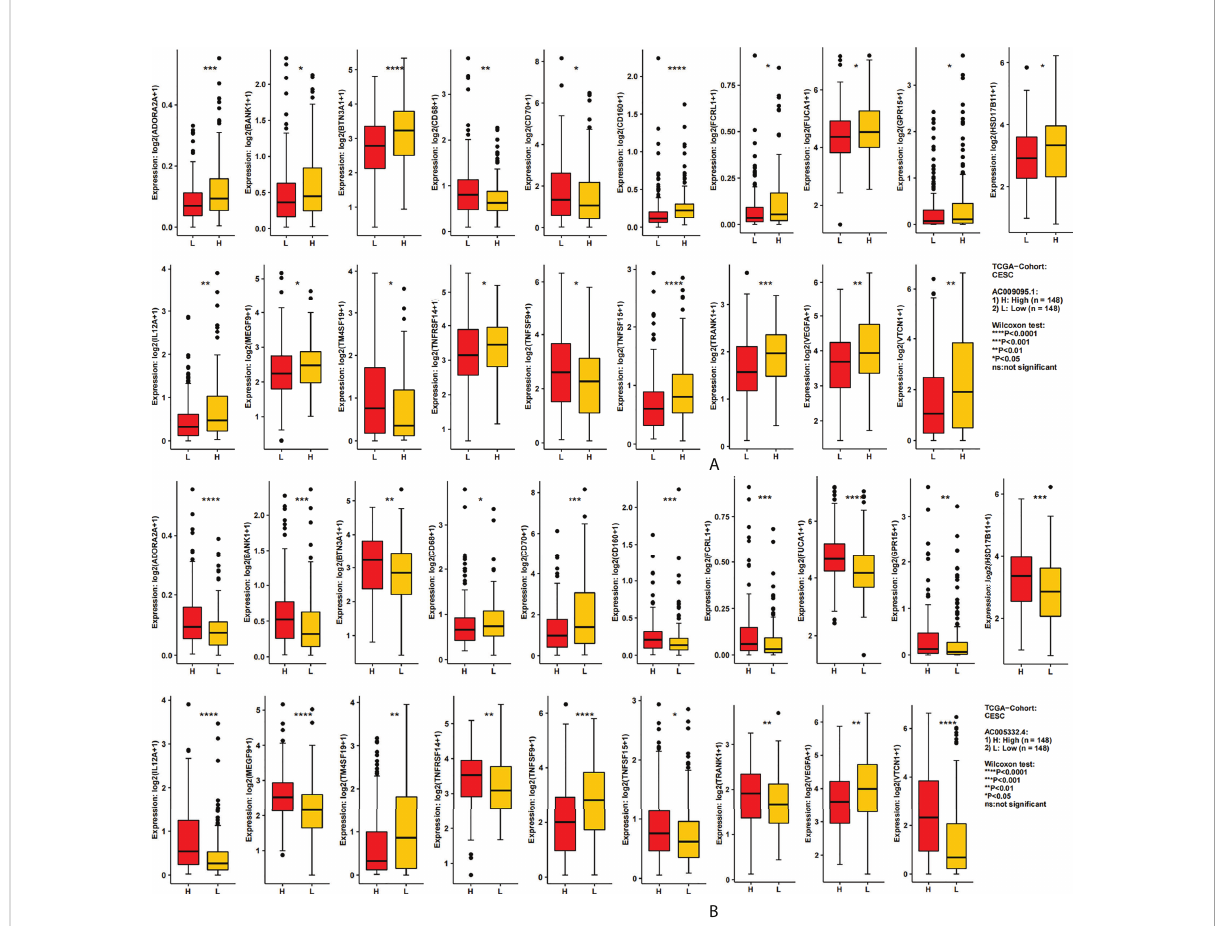
FIGURE 7 The relation between the target lncRNAs and the immune-related genes. (A) Expression of 19 immune-related genes in the AC009095.1 groups. (B) Expression of 19 immune-related genes in the AC005332.4 groups. *p < 0.05, **p < 0.01, ***p < 0.001, ****p <